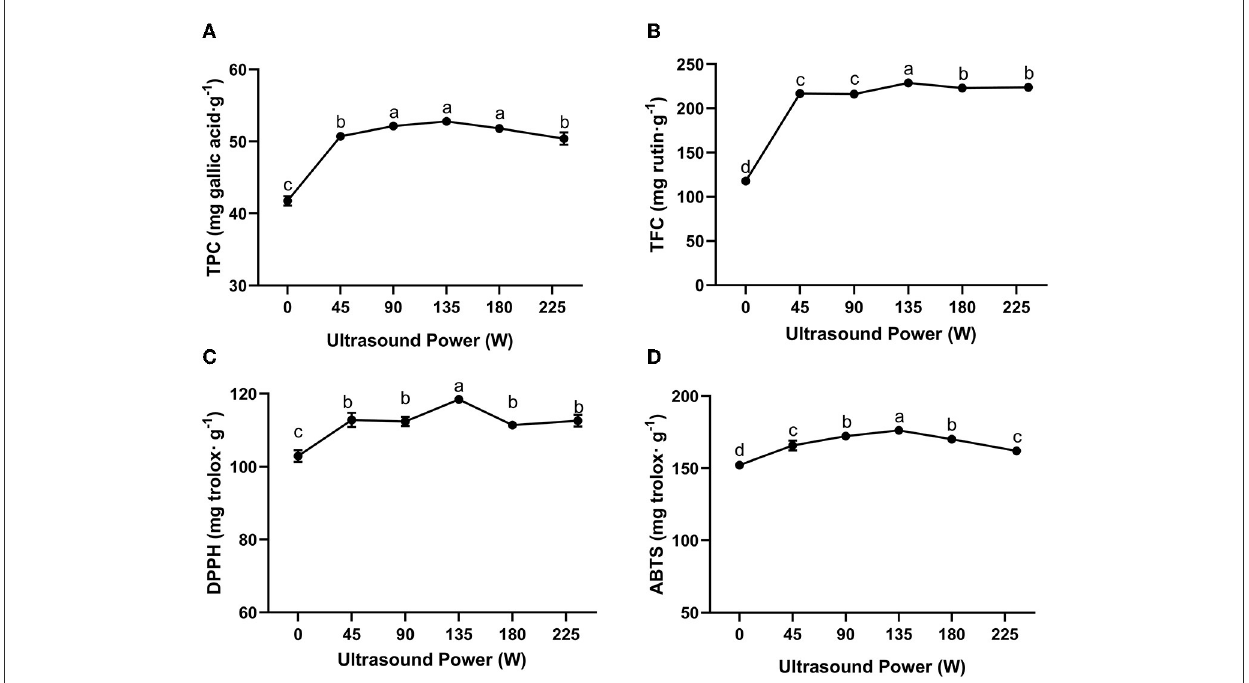
FIGURE2 Effect of ultrasound power on TPC (A) , TFC (B) of propolis extracts and their antioxidant activities meassured by DPPH (C) and ABTS (D) assays (extraction time: 20min). Different superscripts indicate significant differences as estimated by Duncan’s multiple range test ( P < 0.05).